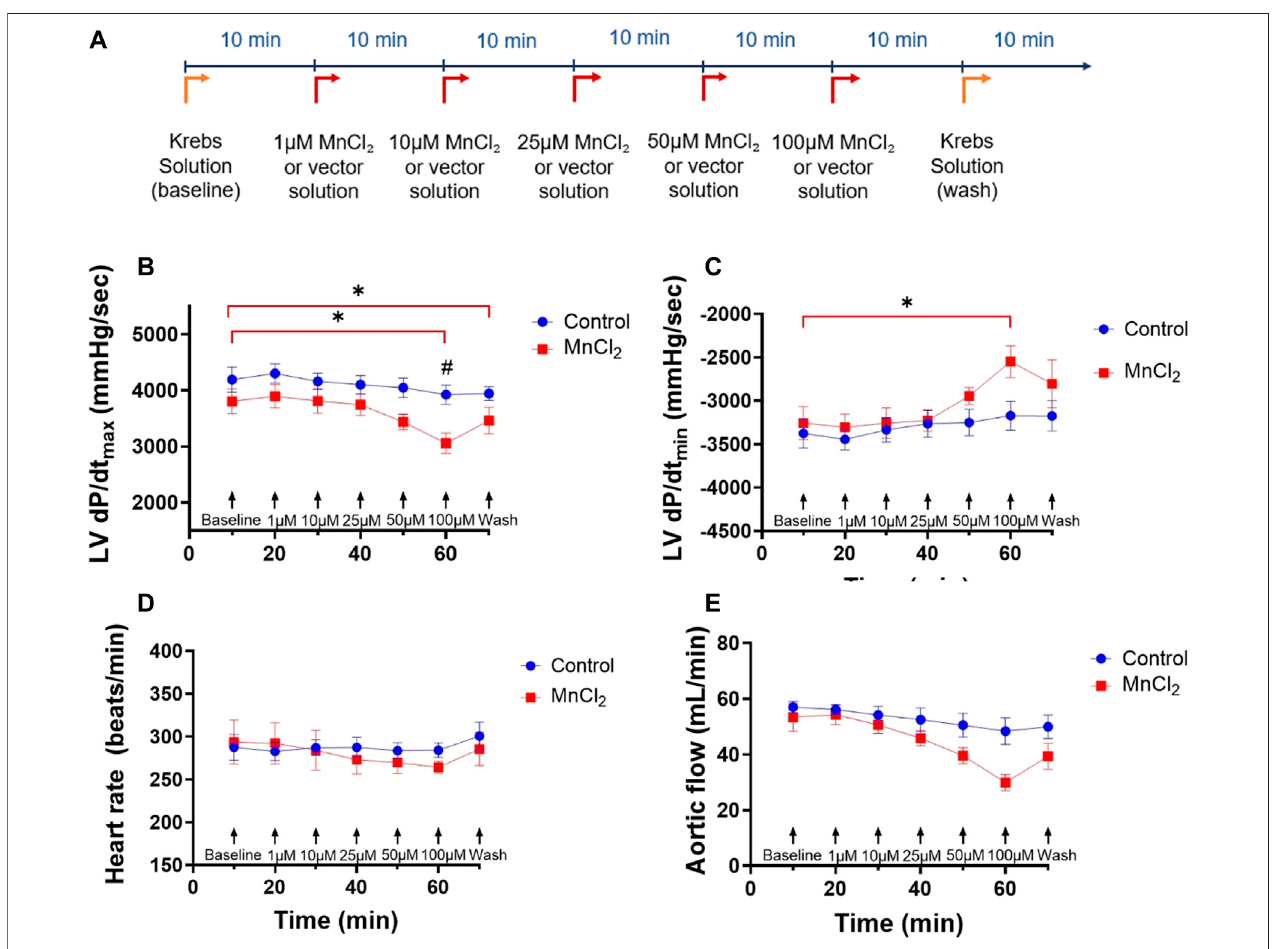
FIGURE 1 | Effects of MnCl 2 on left ventricle hemodynamic properties of rat hearts perfused in working mode. (A) Perfusion protocol for working hearts with or withoutMnCl 2 (B) dP/dt max (C) dP/dt min ofleftventricle (D) heartrate (E) aortic fl owdependingontimeforthecontrolgroup(n=5)(bluedots)andthegroupMnCl 2 ( n =6) (red dots). * p < 0.05 vs. baseline of the same group. # p < 0.05 vs. same condition of control group.